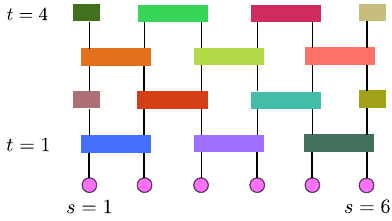
FIG. 1. Structure of the local unitary circuits. The on-site Hilbert space dimension is q . Each two-site gate is an independ- ently chosen q 2 × q 2 unitary matrix commuting with the U(1) ˆ Q charge , defined in Eq.